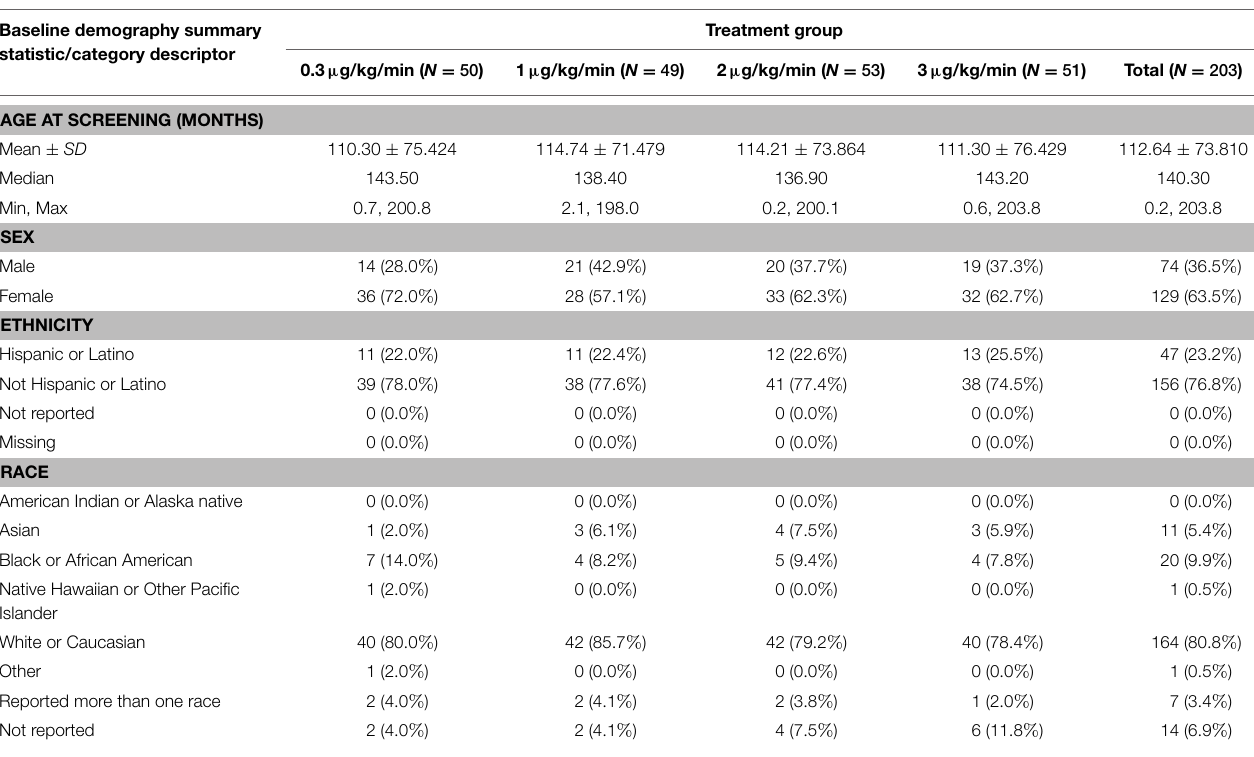
TABLE 2 | Demographic data displayed by randomized treatment group. Baseline demography summary statistic/category